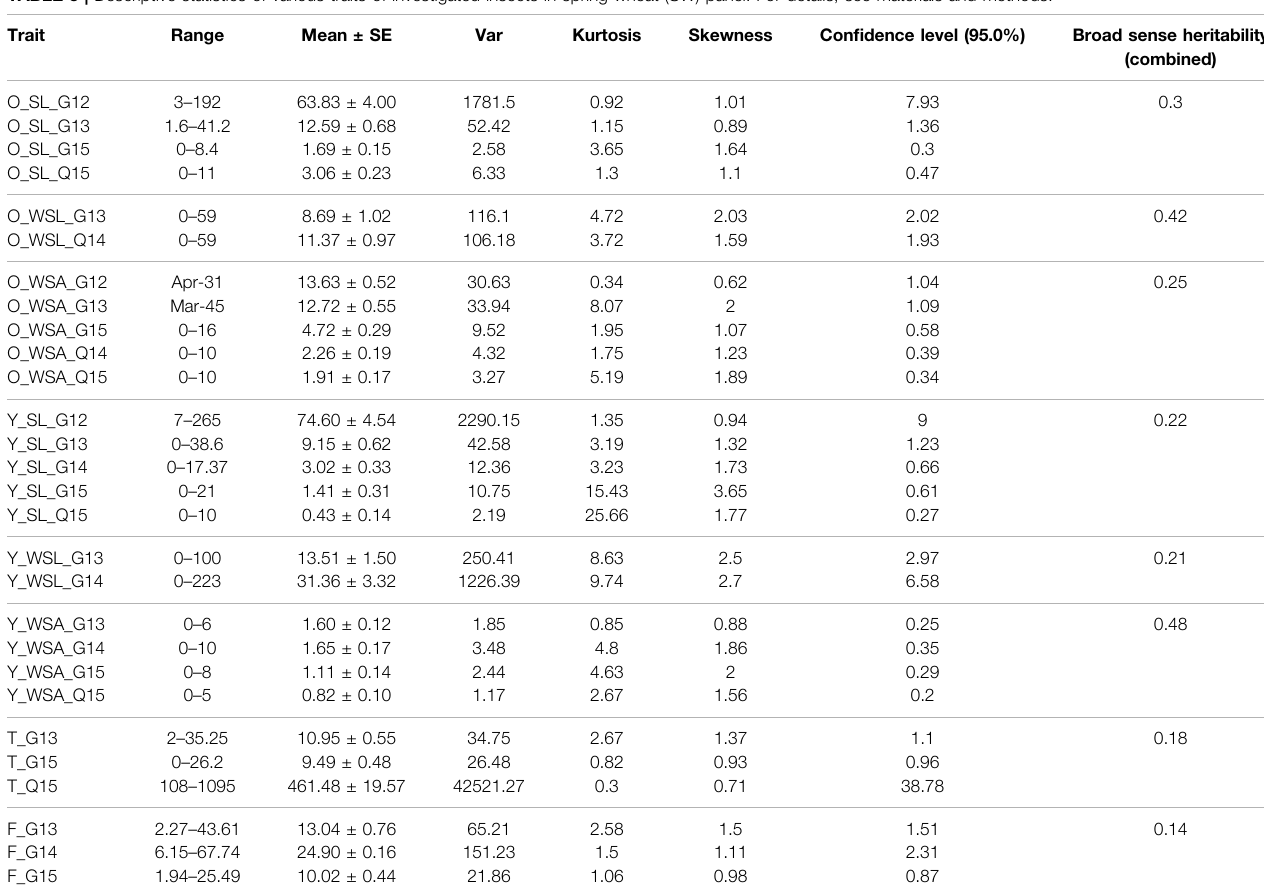
TABLE 3 | Descriptive statistics of various traits of investigated insects in spring wheat (SW) panel. For details, see materials and methods.